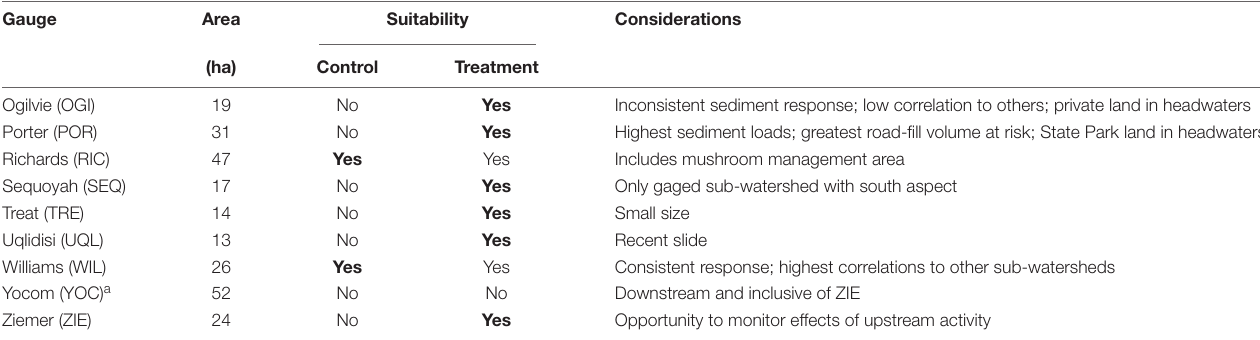
TABLE 2 | Suitability of the South Fork sub-watersheds as control or treatment